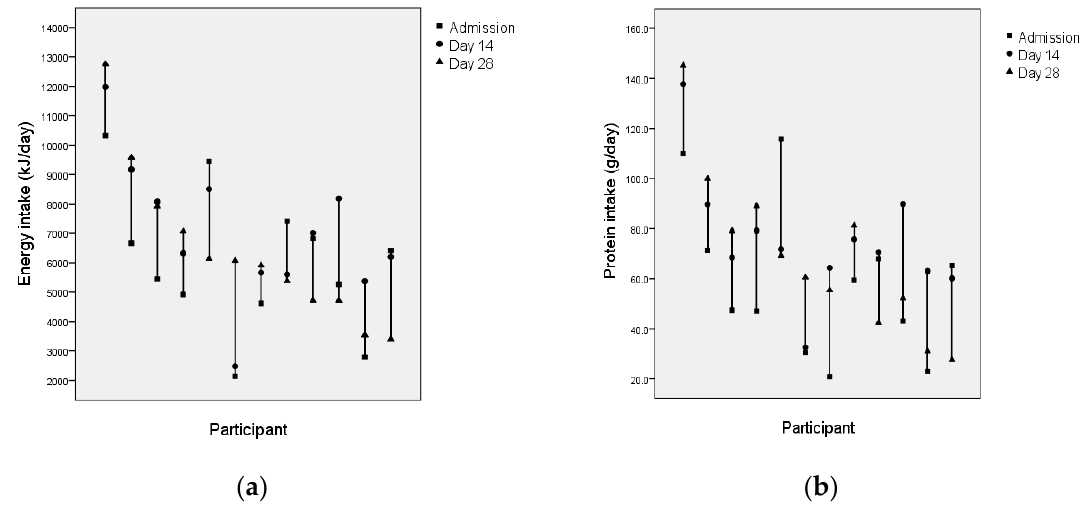
Figure 3. ( a ) Change in energy intake between admission, day 14 and day 28 for individual participants ( n = 12). ( b ) Change in protein intake between admission, day 14 and day 28 for individual participants ( n = 12). Table 2. Multiple regression models of factors associated with change in energy (kJ/day) and protein (g/day) intake between admission and day 14 of subacute inpatient stay ( n = 39). Variable.